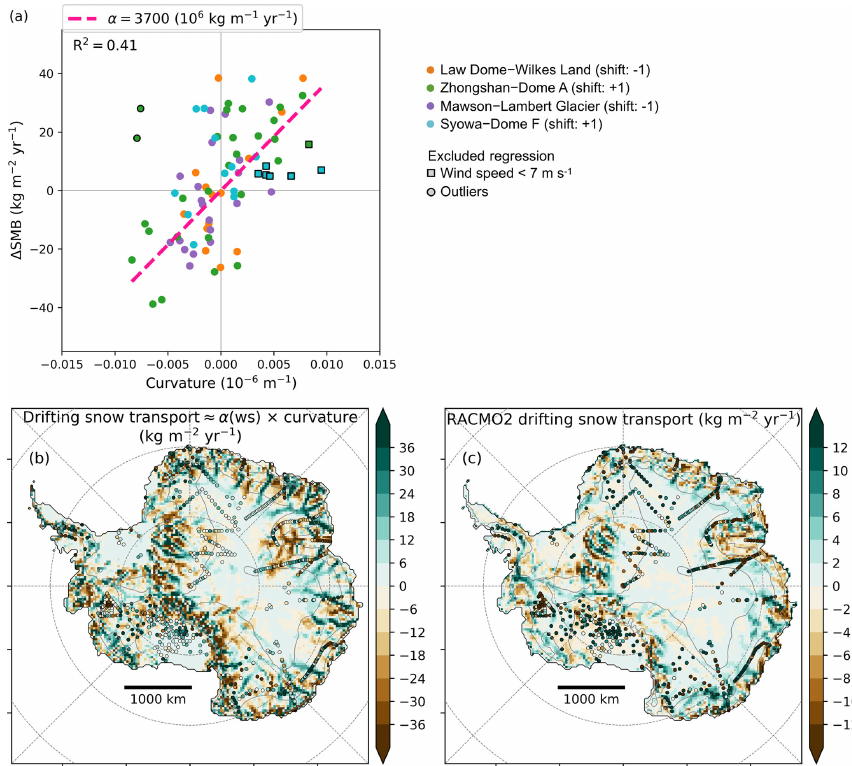
Figure 4. (a) Difference in SMB by grid cell ( (cid:49) SMB) between MAR (ERA-Interim) and observations for four transects (Law Dome–Wilkes Land, Zhongshan–Dome A, Mawson–Lambert Glacier, and Syowa–Dome F) vs. surface curvature on MAR grid. Curvature is shifted by ± 1 grid cell according to the maximum correlation with (cid:49) SMB (Fig. S10). Linear regression through the origin is plotted with a pink dashed line. We excluded the regression of two outliers (dots with black outlines) and seven data for which MAR annual 10m wind speed is lower than 7m s − 1 (squares with black outlines). (b) Estimate of mean annual drifting snow transport based on a scaling of the curvature: drifting snow transport (kgm − 2 yr − 1 ) = α (10 6 kgm − 1 yr − 1 ) × curvature (10 − 6 m − 1 ), with α = 0kgm − 1 yr − 1 for wind speed lower than 5ms − 1 , α = 370010 6 kgm − 1 yr − 1 for wind speed greater than 9ms − 1 , and α linearly increasing as a function of wind speed in between, around the 7ms − 1 wind speed threshold. Wind speed is the annual mean of 10m wind speed modelled by MAR (ERA-Interim). Coloured dots show the difference between MAR SMB and observed SMB with the same colour scale. (c) Mean annual drifting snow transport flux in RACMO2 on average for 1979–2015 (kgm − 2 yr − 1 ). Coloured dots show the difference between MAR SMB and observed SMB with the same colour